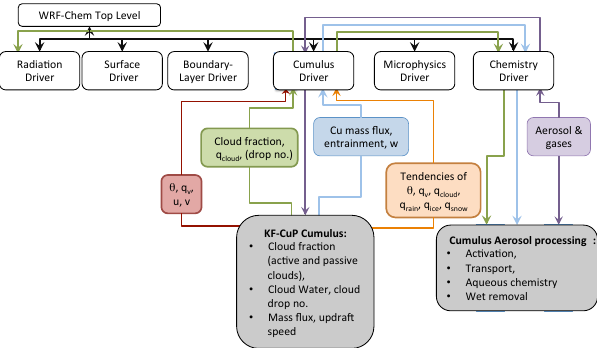
Figure 1. Summary of modifications to the standard implementa- tion of WRF-Chem. Colored boxes indicate information passed be- tween subroutines related to the thermodynamics (red), cloud mi- crophysical and macrophysical properties (green), cloud dynamics (blue), thermodynamic tendencies (orange) and aerosol and trace gases (purple), while gray boxes indicate the new or modified pa- rameterizations applied in WRF-Chem. Arrows indicate informa- tion flow within the model. Note that the droplet number generated in the KF–CuP parameterization is not currently used in the radia- tion